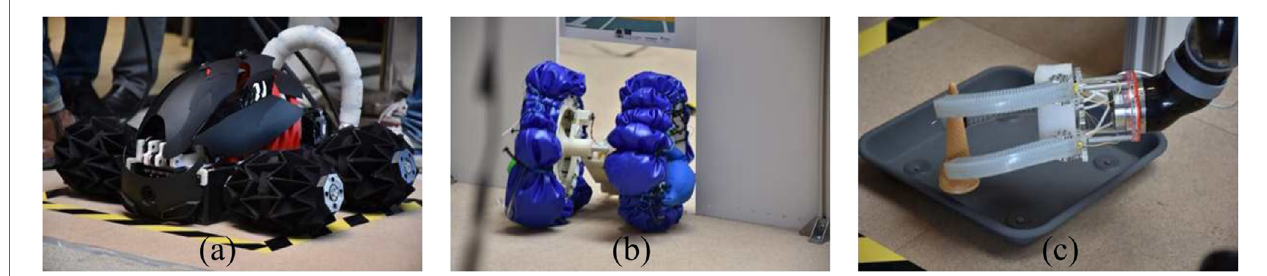
FIGURe 7 | the Grand Challenge winner (A) had origami wheels and a flexible manipulating arm (white, in the back) . The locomotion race winner (B) had inflatable air-chambers attached to a wheeled device, while the manipulation winner (C) featured a pneumatic three-finger